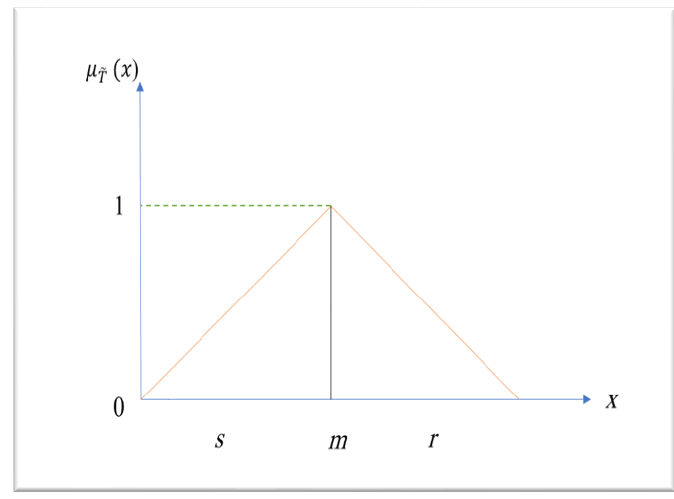
Figure 1. The membership functions of the triangular fuzzy number. The operational laws of triangular fuzzy number (cid:101) T 1 = ( s 1 , m 1 , r 1 ) and (cid:101) T 2 = ( s 2 , m 2 , r 2 ) are blazon as consecutive formulas as an addition (2), multiplication (3), divi- sion (4), and reciprocal (5) of the fuzzy numbers.